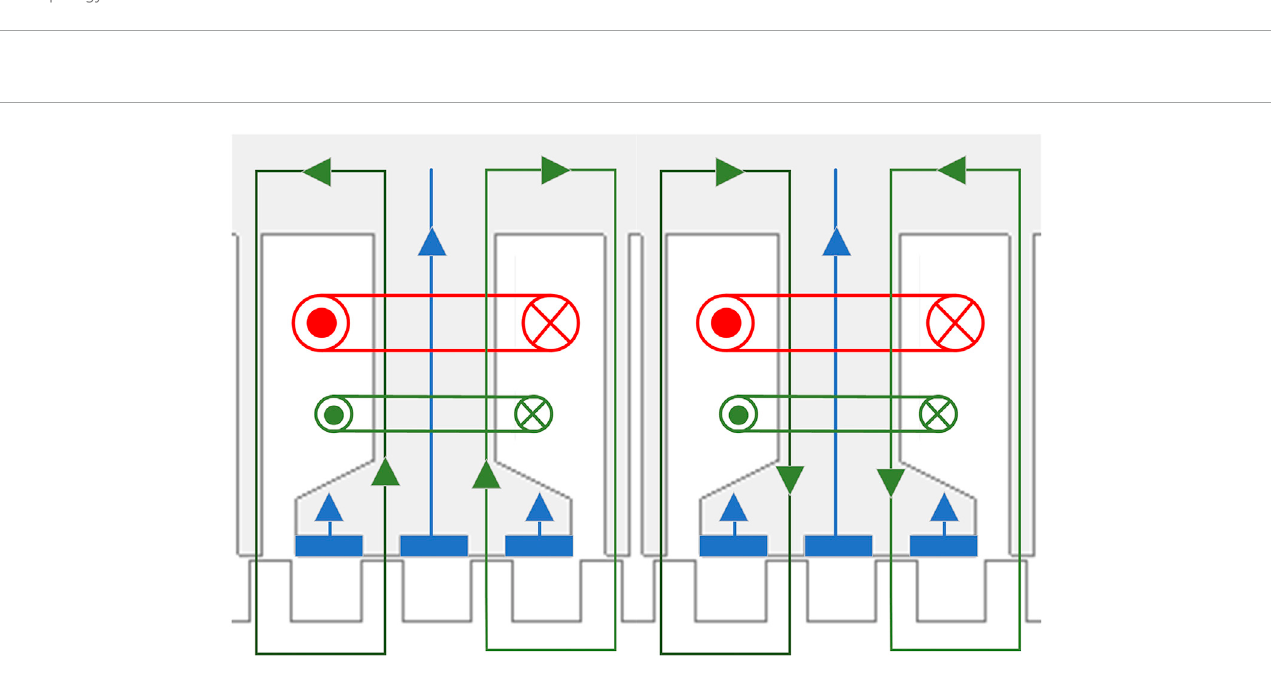
FIGURE 1 Topology of the motor.